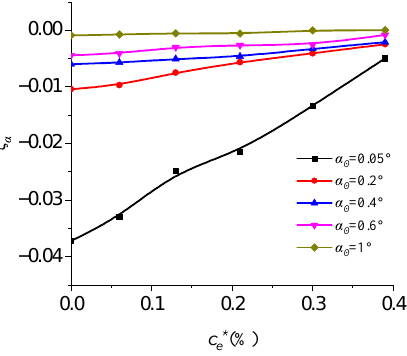
Figure 14. The damping ratios of self-excited vibrations under different guide vane openings as a function of end wall